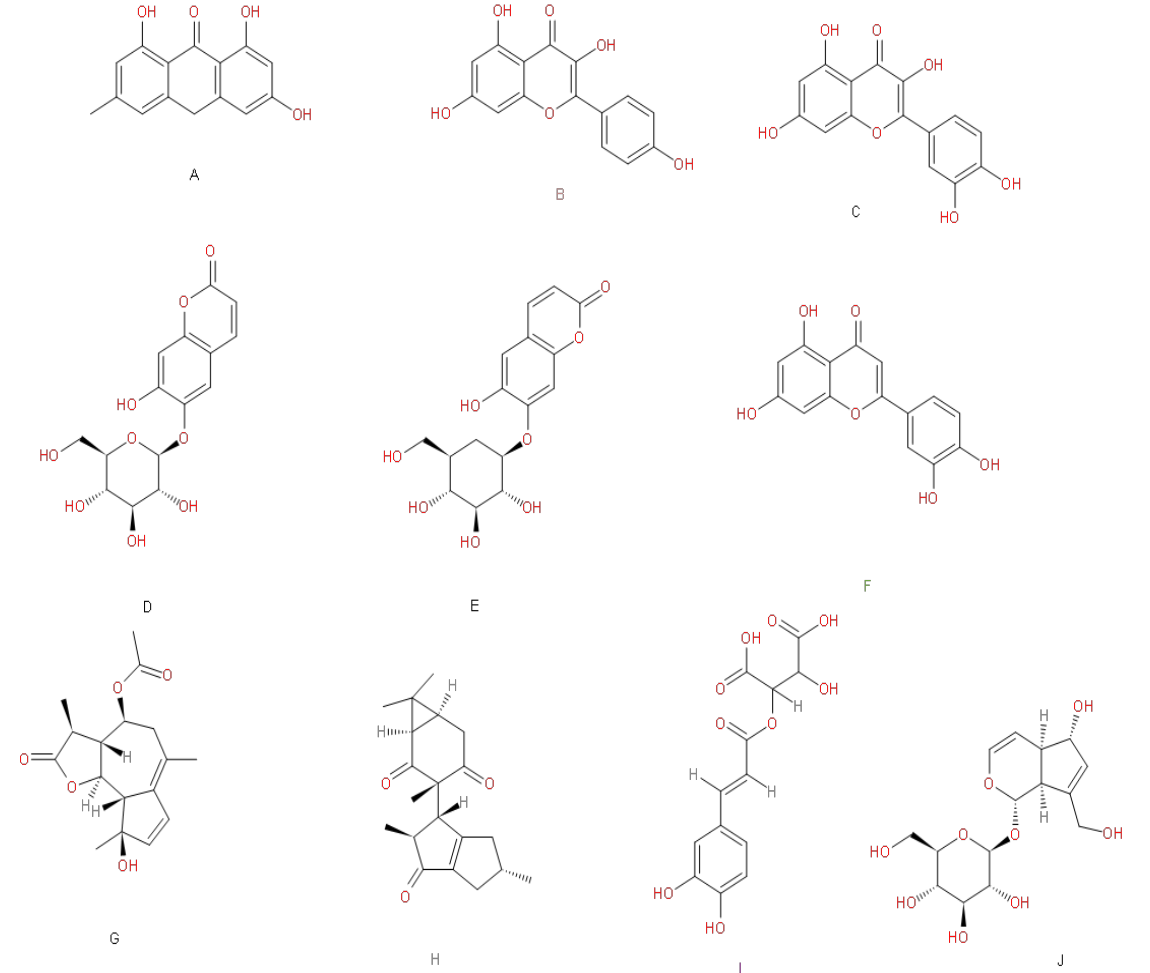
Figure 3. Compounds with chemical properties as leaders. According to the chemoinformatic analysis, we present the ten compounds’ molecular structures that meet the criteria for further analyses, and the Mexican natural materials from which they derive. ( A ) emodin anthrone ( Aloe vera) , ( B ) kaempferol ( Urtica dioica, Passiflora incarmata, Prunus pérsica L., Tilia mexicana and Tilia europea ), ( C ) quercetin ( Passiflora incarmata , Tilia europea , Taraxacum officinale , Matricaria recutita , Prunus pérsica L., Tilia mexicana and Urtica dioica) ( D ) aesculin ( Taraxacum officinale ), ( E ) cichoriin ( Taraxacum officinale ), ( F ) luteolin ( Scoparia dulce L., Taraxacum offcinale and Passiflora incarmata ), ( G ) matricin ( Matricaria recutita ), ( H ) riolozatrione ( Jatropha dioica ), ( I ) monocaffeoyl tartaric acid ( Taraxacum officinale ), ( J ) aucubin ( Verbascum densiflorum ).